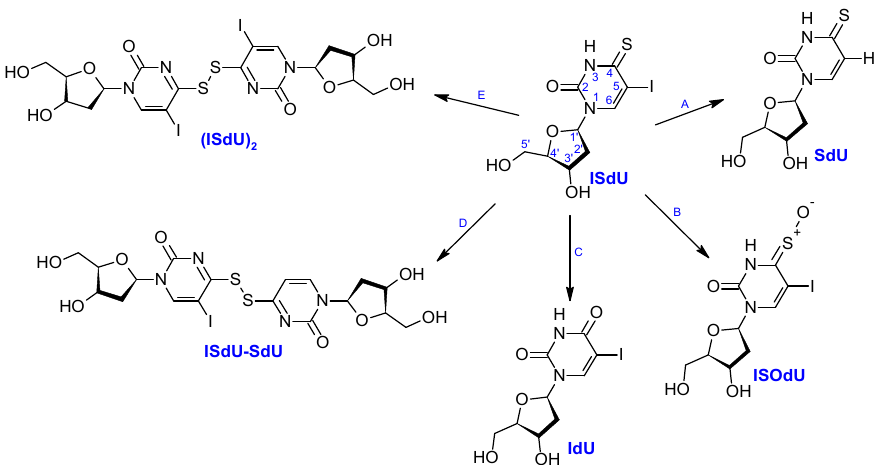
Scheme 1. LC–MS/MS determined products of ISdU X-ray radiolysis. The nucleoside numbering is shown in the substrate structure.